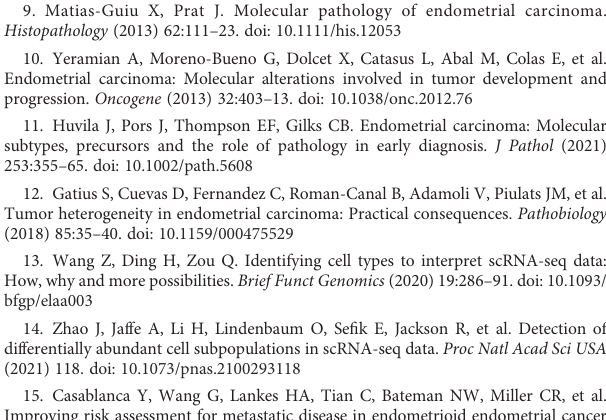
The outgoing signals from each cell type. The line width repents the strength of the signal. SUPPLEMENTARY FIGURE 2 MDK-NCL transfers the strongest signal. (A) Comparison of the signi fi cant ligand-receptor pairs between cells, which contribute to the signaling from fi broblasts, epithelial cells, macrophage and ciliated cells to T cells, endothelial cells, NK cells, Mast cells and B cells. (B) Comparison of the signi fi cant ligand-receptor pairs between cells, which contribute to the signaling from epithelial cells and ciliated cells to fi broblasts, T cells, endothelial cells, NK cells, macrophage, Mast cells and B cells. (C) Contribution of each Ligand-Receptor (L-R) pairs in the communication between the cells. SUPPLEMENTARY FIGURE 3 Interaction between epithelial cells and endothelial cells. (A) Outgoing and incoming interaction strength of the subclusters of epithelial cells and endothelial cells. En. 0 – En. 2, subclusters 0 – 2 of endothelial cells; and Ep. 0 – Ep. 4, subclusters 0 – 4 of epithelial cells; (B) Heatmaps showing outgoing and incoming interaction strength as well as involved pathways. (C) Contribution of each Ligand-Receptor (L-R) pairs in the communication between the subclusters of epithelial cells and endothelial cells. SUPPLEMENTARY FIGURE 4 Signaling atlas of the top 20 Ligand-Receptor pairs. SUPPLEMENTARY FIGURE 5 Validation of MK signaling in GSE120490. (A) Lollipop chart showing the signi fi cant associations between the 8 genes and the scores estimated by “ estimate ” package. *, P <0.05; **, P <0.01; ***, P <0.001. (C) Scatter plots showing the Spearman ’ s corrections between NCL/MDK and